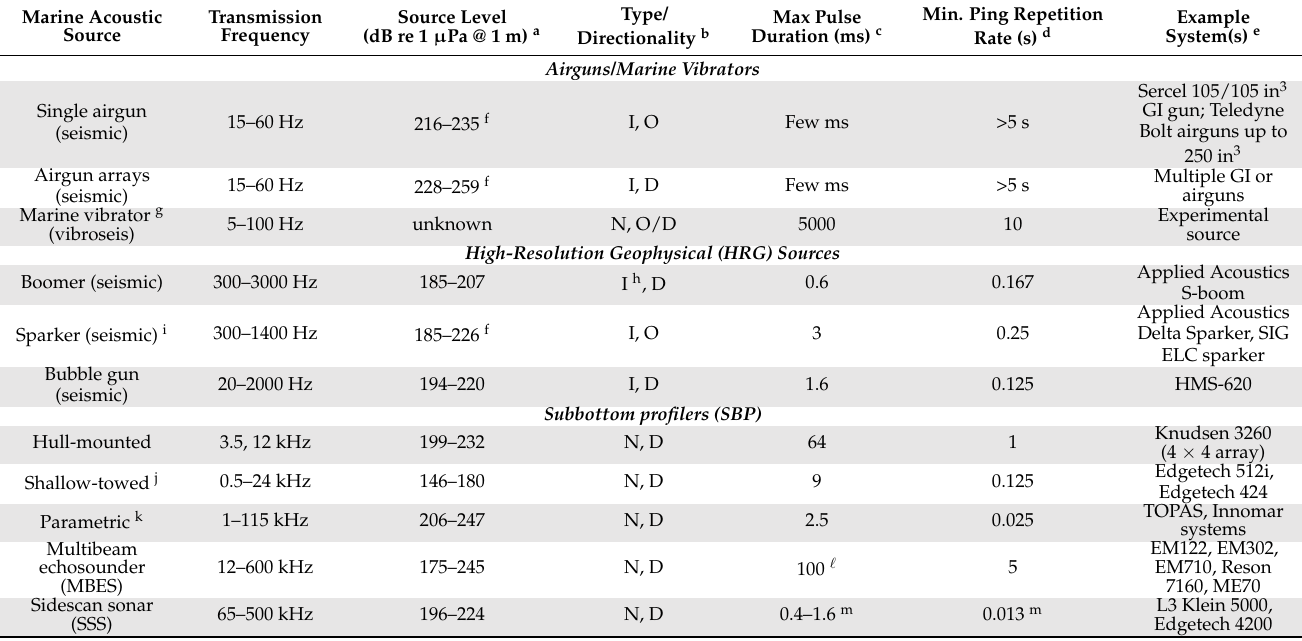
Table 1. Selected marine acoustic